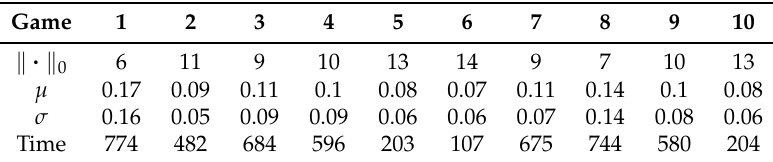
Table 3. Performance of Dense Shapley-Snow Algorithm.